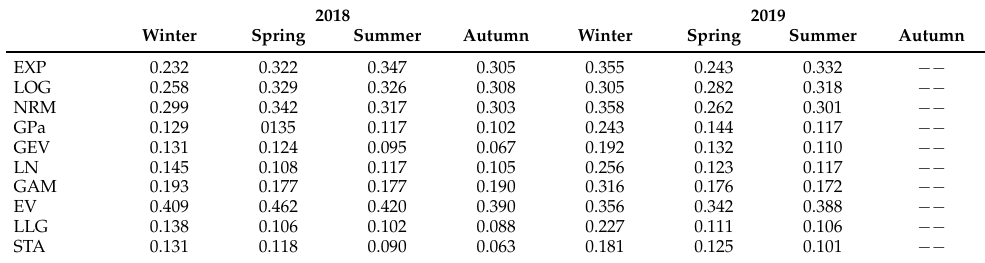
Figure 7. Probability density functions of fog events over time for the Maximum Likelihood approach fixing the threshold to 300 m. The CDF is located in the insets. Each row corresponds to a season and each column to a year. Table 12. KS-distances results for the Maximum likelihood approach, for the 50 m threshold. Estimations of autumn 2019 are not possible since there are only three low-visibility events with a threshold under 50 m in that